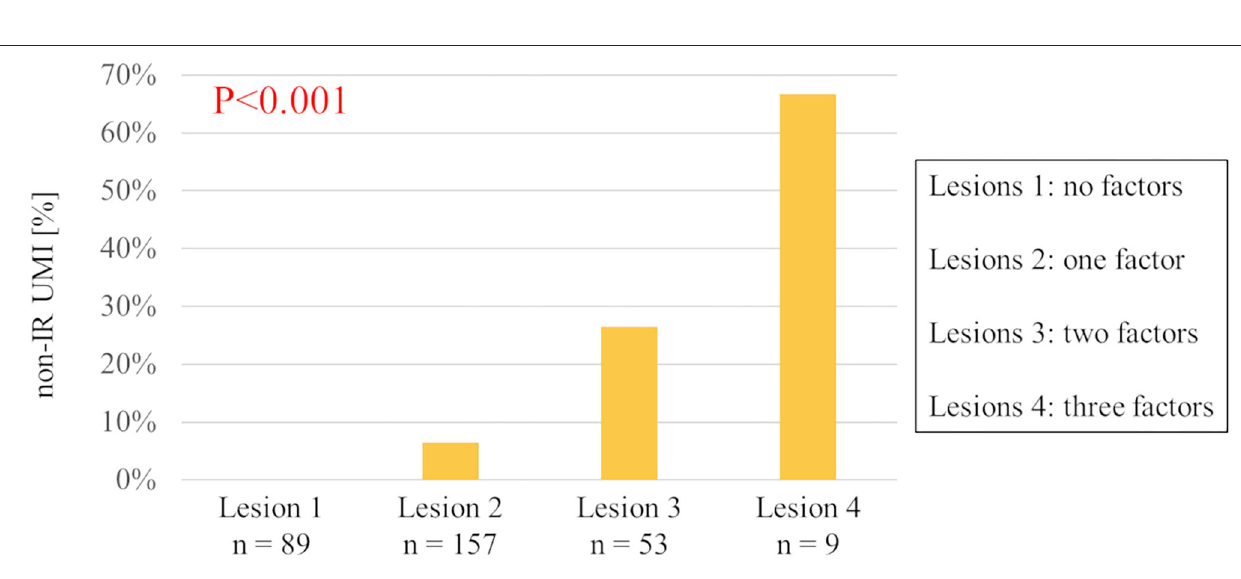
FIGURE 3 | The prevalence of non-IR UMI stratified by the numbers of three predictive CCTA features. Relevant CCTA factors assessed are (1) peri-coronary fat attenuation index > -64.3, (2) Agatston score > 30.0, and (3) CCTA-derived stenosis > 55.2%. Non-IR UMI, non-infarct-related unrecognized myocardial infarction; CCTA, coronary computed tomography